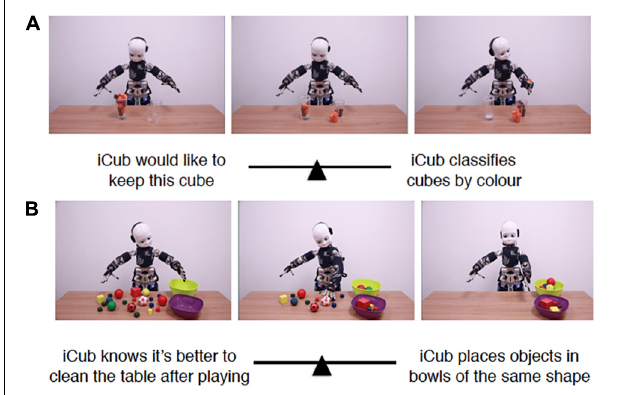
FIGURE 4 | Two scenarios with highest mechanistic scores. (A) Shows Item 28 which received the score 10.07 on average, while (B) depicts Item 31 which received the score of 11.97 on